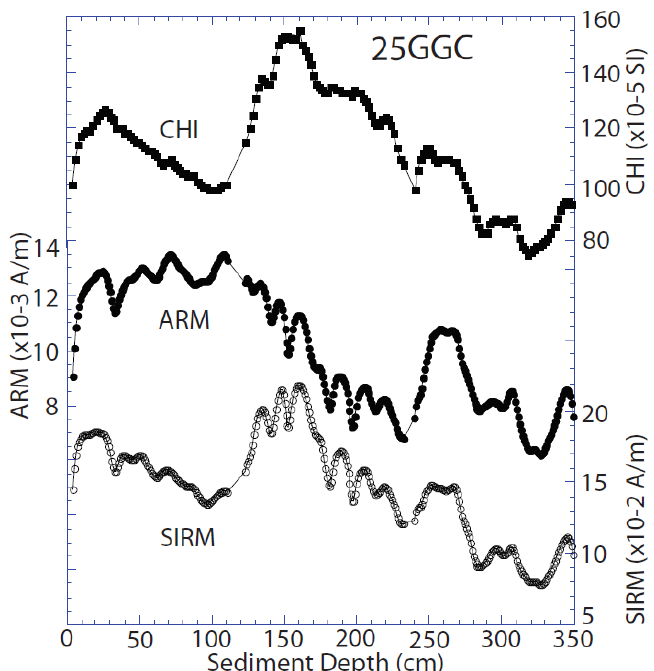
Figure 3. Rock magnetic intensity variability of gravity core 25GGC. Individual rock magnetic intensities are shown as Chi, anhysteretic remanence (ARM), and saturation isothermal remanence (SIRM) values. See text for further discussion.